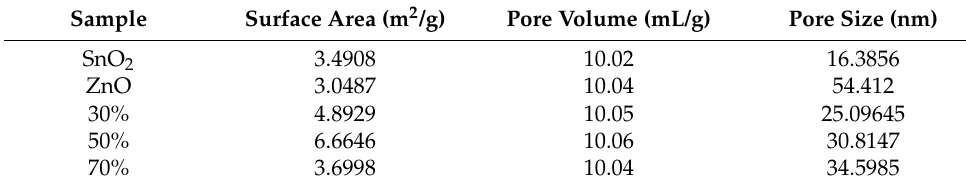
Figure 5. The adsorption–desorption isotherm, the pore size plot and the surface area plot of the materials of ( a ) SnO 2 , ( b ) ZnO, ( c ) 30:70, ( d ) 50:50 ( e ) 70:30 and ( f ) Linear plot relative to pressure of surface area. Table 1. The average surface area, pore volume and the pore size of the